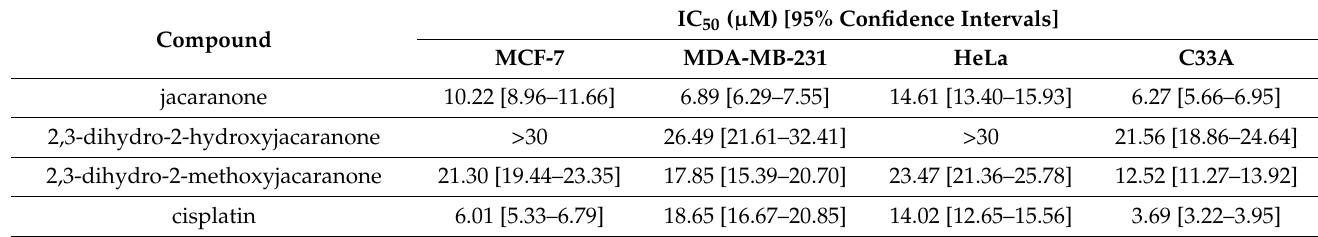
Figure 1. Compounds isolated from C. pulchra . Table 1. Antiproliferative activity of the isolated jacaranone derivatives.